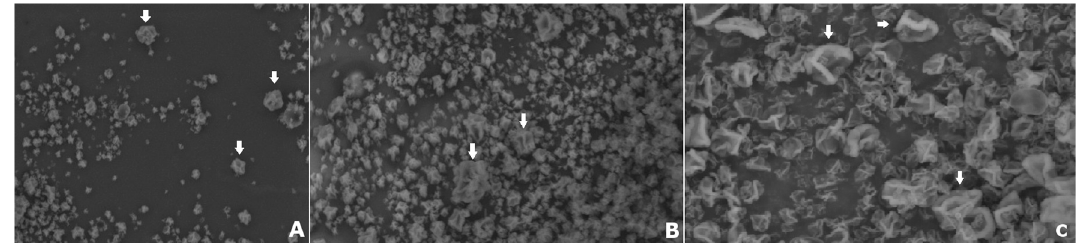
Table 4. Chromatographic parameters of the phenolic compounds analyzed by HPLC-DAD. Figure 9. SEM micrographs at magnification of 1500X ( A , B ) and 3000X ( C ). Arrows indicating particles similar to raisins. Standard Regression Equation